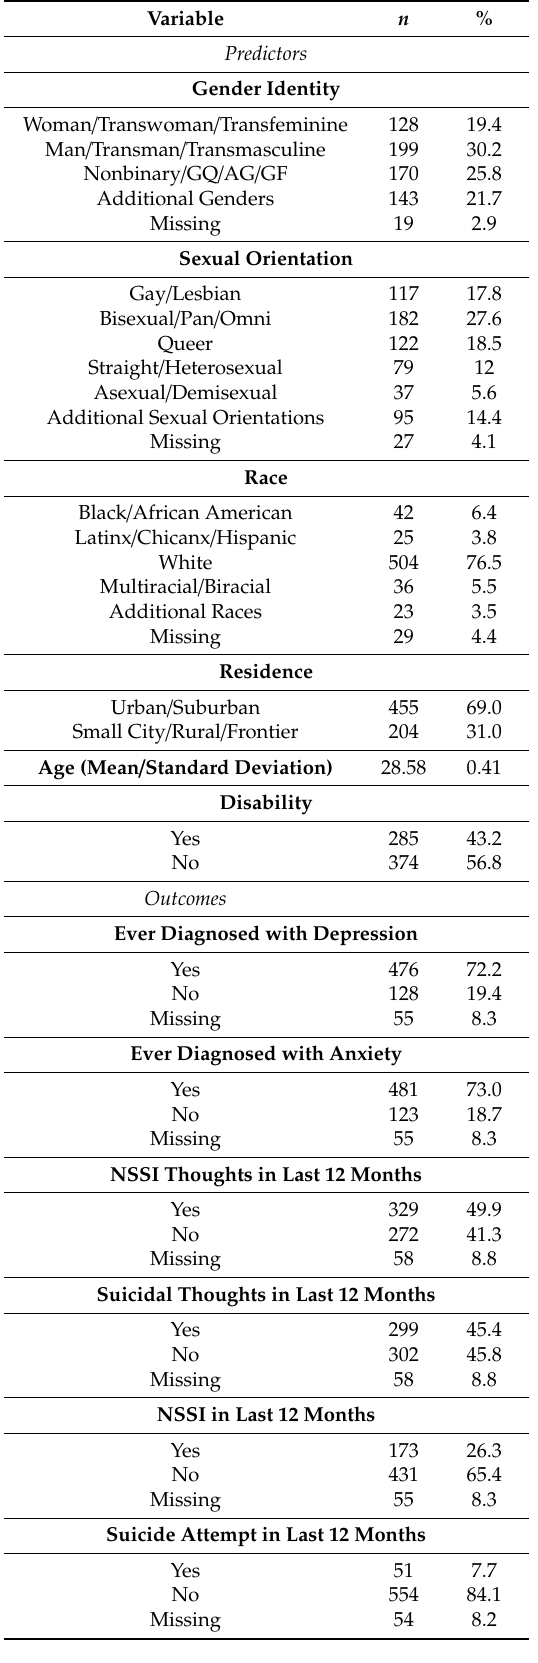
Table 1. Demographic Breakdown ( n =